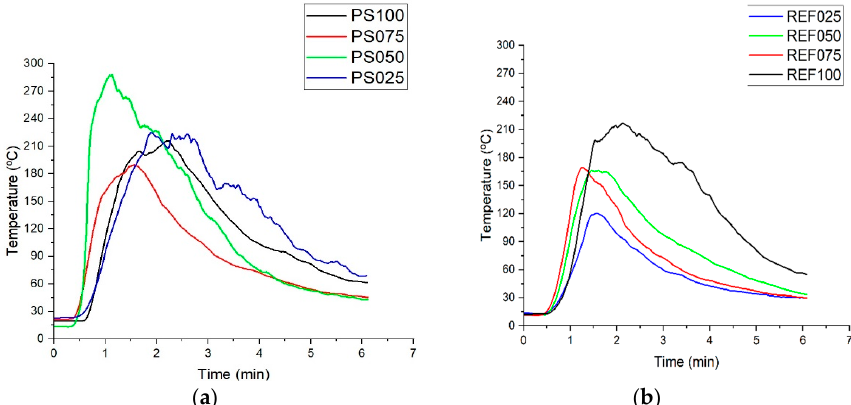
Figure 5. The temperature 10 cm from the basket fuel for ( a ) tests with the protective device and ( b ) reference tests.